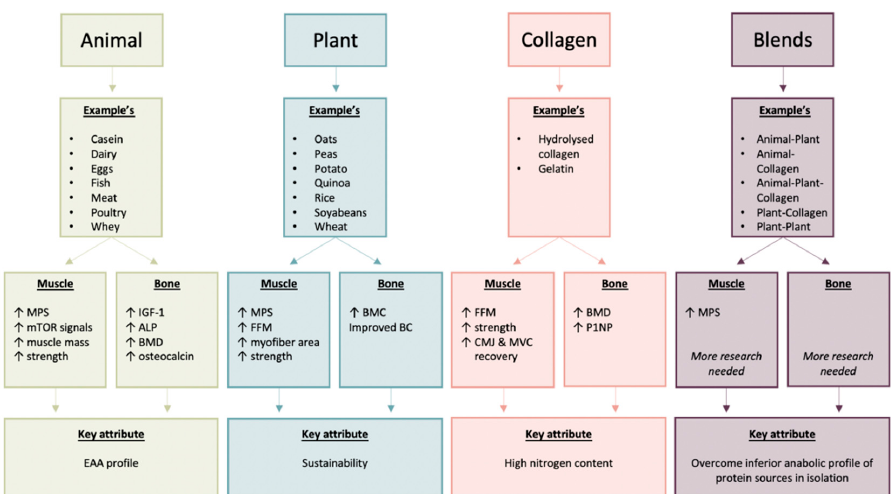
Figure 1. Summary of the key musculoskeletal benefits of animal, plant, collagen and blended dietary proteins. Abbreviations: ALP, alkaline phosphatase; BC, body composition; BMC, bone mineral content; BMD, bone mineral density; CMJ, counter movement jump; EAA, essential amino acids; FFM, fat free mass; IGF-1, insulin-like growth factor 1; MPS, muscle protein synthesis; mTOR, mechanistic target of rapamycin; MVC, maximal voluntary contraction; P1NP, amino-terminal propeptide of collagen